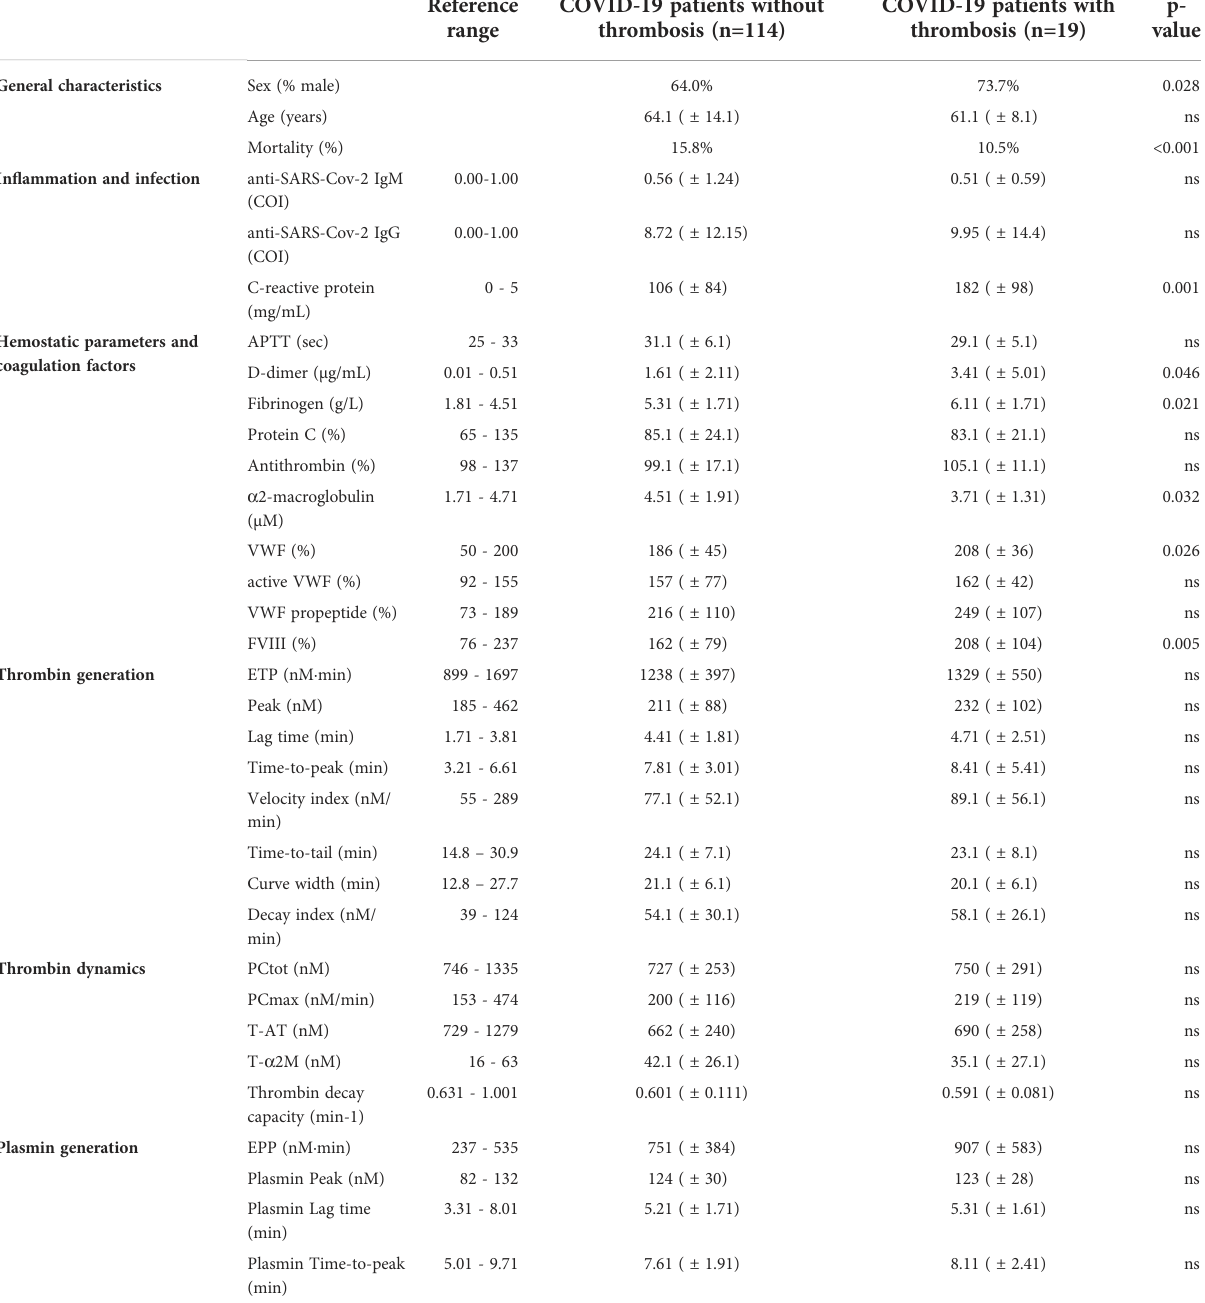
TABLE 1 General characteristics and laboratory tests of the hospital admissions patient (n=133) cohort